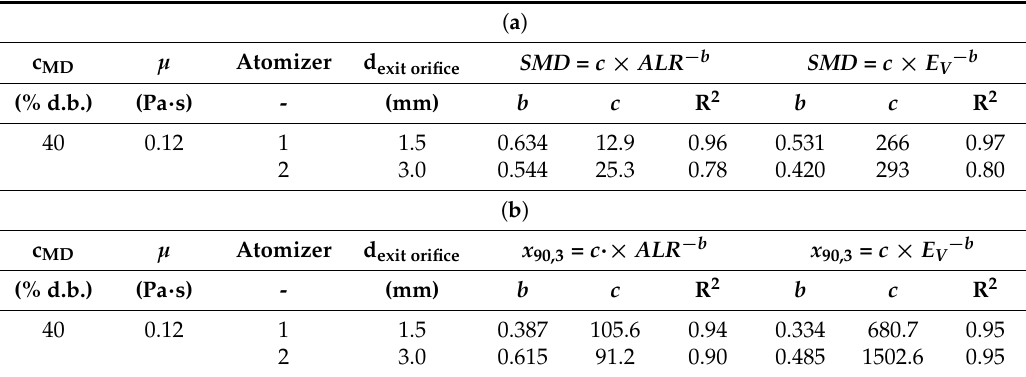
Table 6. ( a ) Fit parameters b and c , as well as determination coefficient R 2 for correlations between SMD and E V . ( b ) Fit parameters b and c , as well as determination coefficient R 2 for correlations between x 90,3 and E V